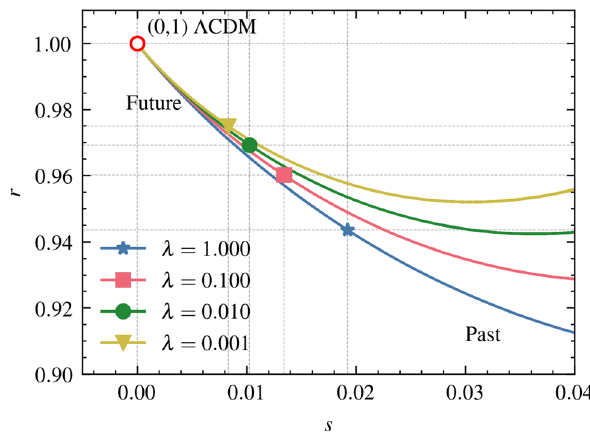
Fig. 11 Statefinder diagnostic for different values of λ . The sectors divided by dotted lines about the markers represents the past and the future(with (cid:12) m 0 = 0 . 315and H 0 = 67 . 4km/s/Mpc[78]).Themarkers represents the present time for different λ